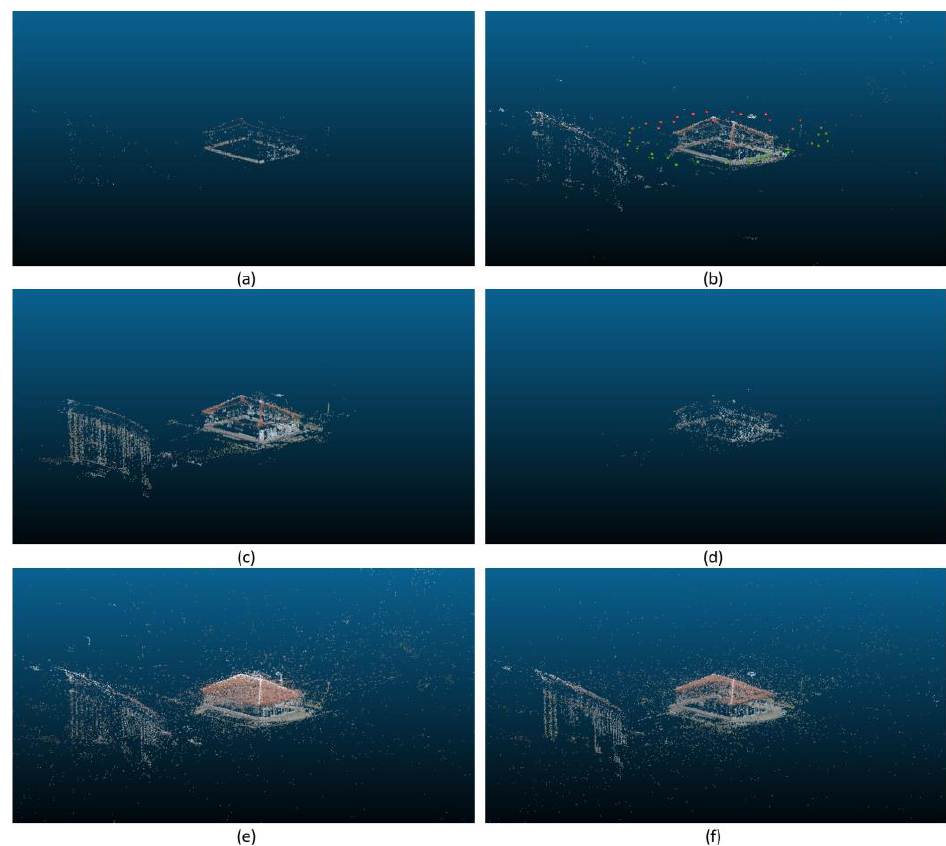
Figure 8. Sparse point clouds generated in: ( a ) ContextCapture; ( b ) GRAPHOS; ( c ) Metashape; ( d ) PhotoScan; ( e ) Pix4DMapper; ( f ) RealityCapture.